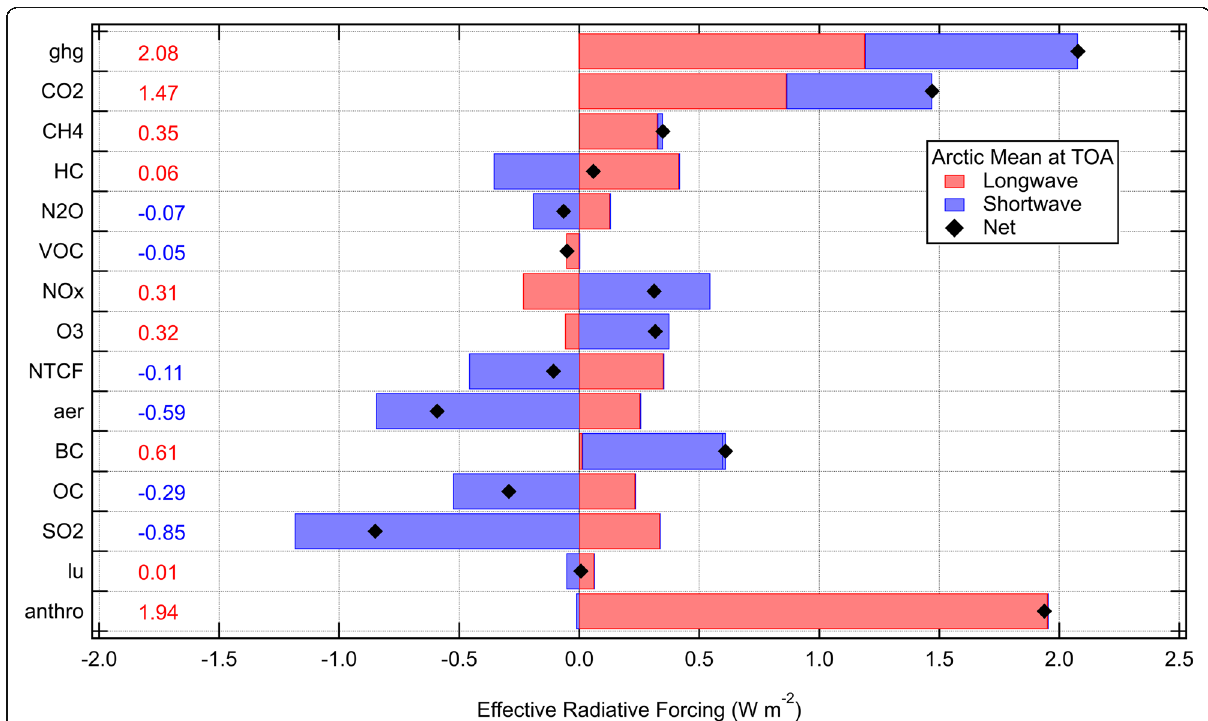
Fig. 8 Same as Fig. 2 but for the Arctic mean ERF estimates. The Arctic region is defined as the latitude range of 60 – 90°N. The ERF values